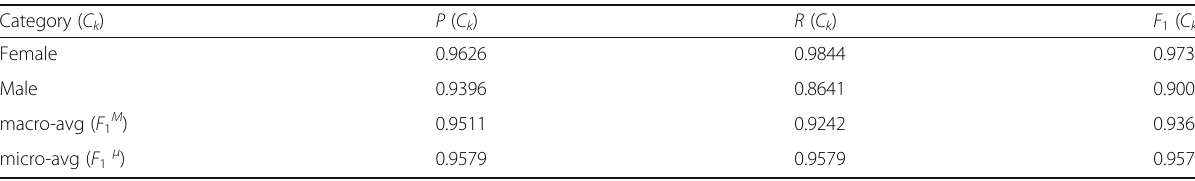
Table 8 Results with norm-TF with cross validation = 10